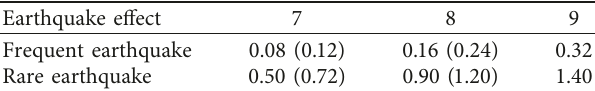
Table 4: Displacement amplitudes under rare earthquake conditions.